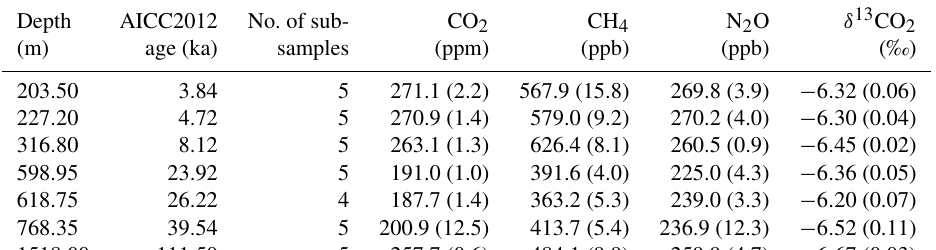
Table 2. Analyzed EDC samples. Each sample was ∼ 9cm long, yielding four to five subsamples. Standard deviations (SDs) are 1 σ and given in parentheses.